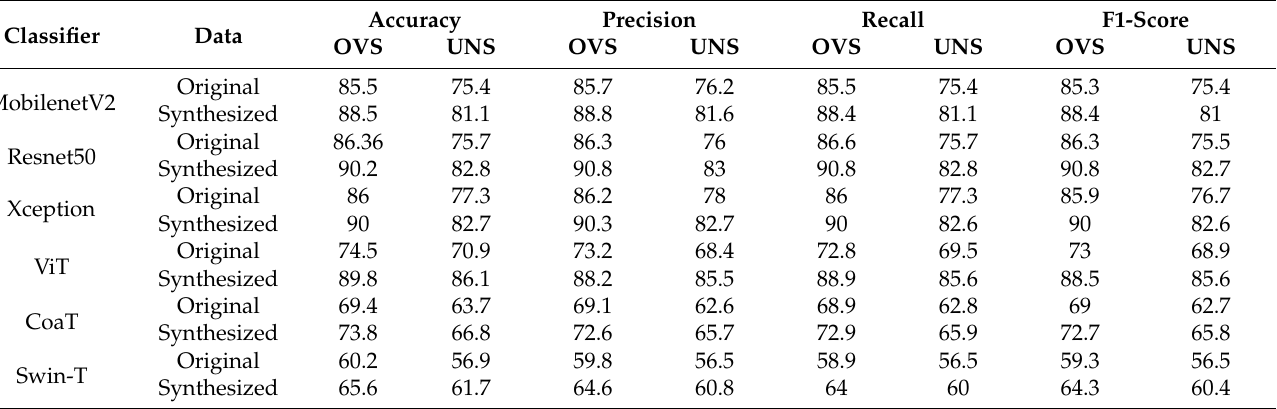
Table 3. Performance comparison for classifying corneal conditions among obstetric models after balancing data (%).